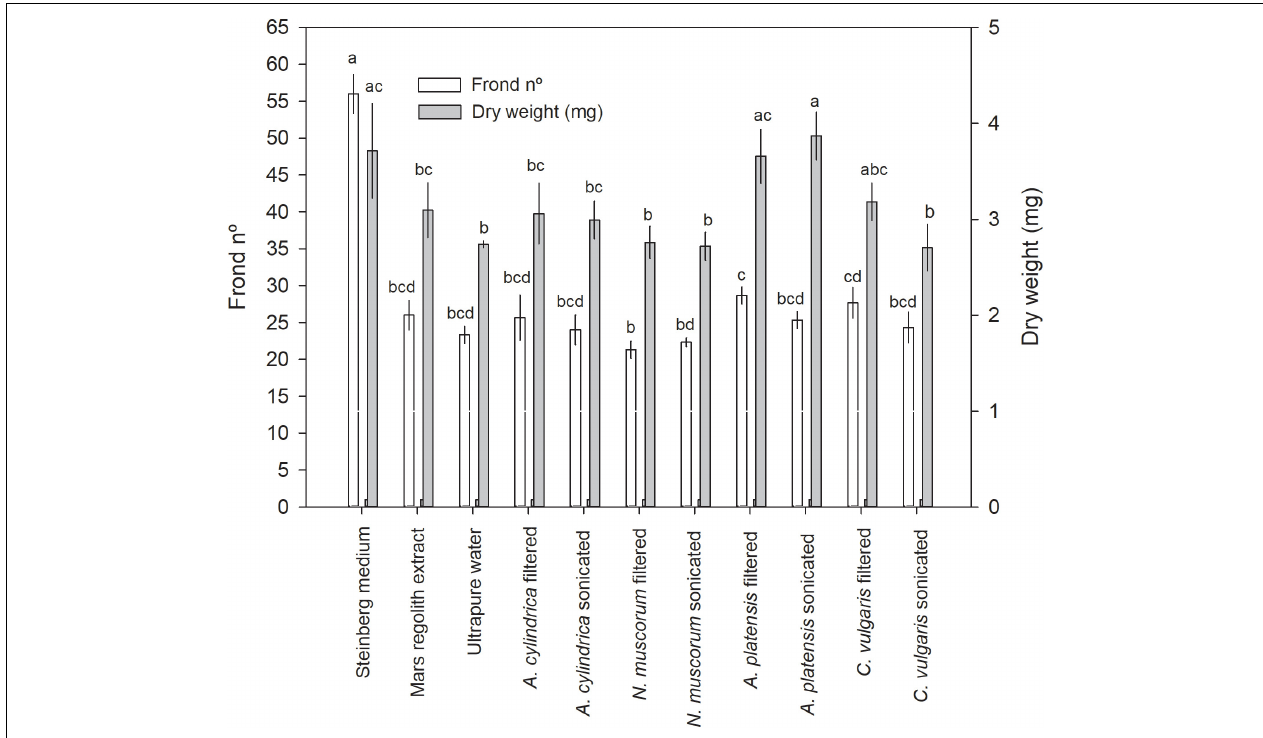
FIGURE 2 | Lemna minor biomass yield (in frond number or dry weight) after 7 days of culturing in Steinberg medium, Mars regolith extract, ultrapure water, and cyanobacteria/microalgae grown in Mars regolith extract, either filtered or sonicated. Bars represent the mean of three replicates and the error bars represent the standard deviation. Different letters indicate significant differences among treatments (Tukey’s test; p <